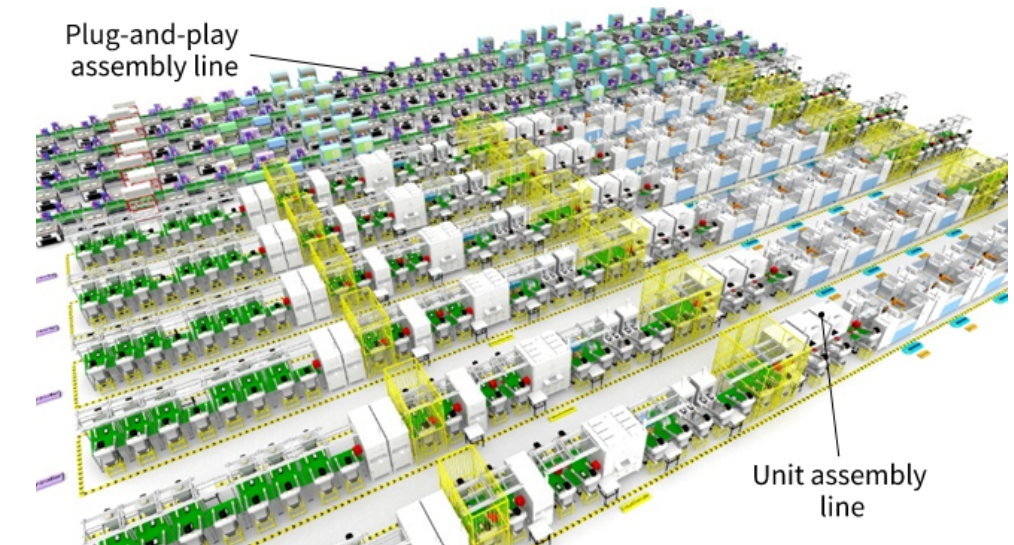
Figure 4. The layout of the Hybrid Assembly